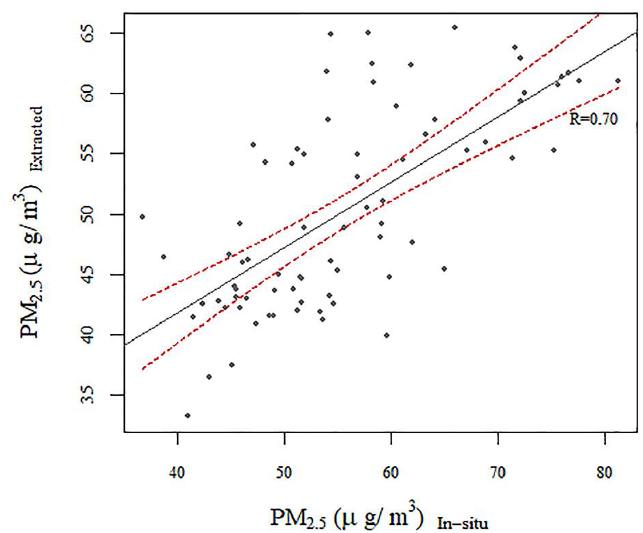
Figure 3. Scatter plot of regulatory stations that monitored PM 2.5 concentrations and remote-sensed PM 2.5 concentrations. Dashed red lines represent a 95% confidence interval of the fitting line.